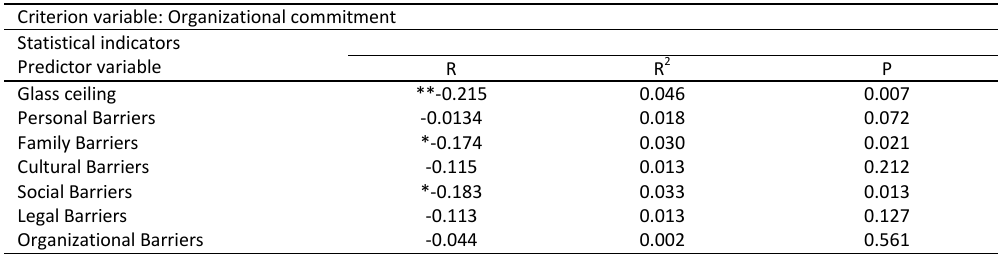
Table 1. Correlation between dimensions of glass ceiling and women employees' organizational Criterion variable: Organizational commitment Statistical indicators Predictor variable